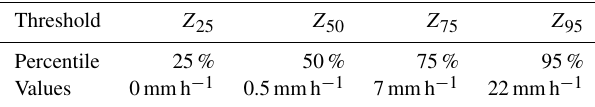
Table 5. Thresholds values obtained for the nine rainfall events con-